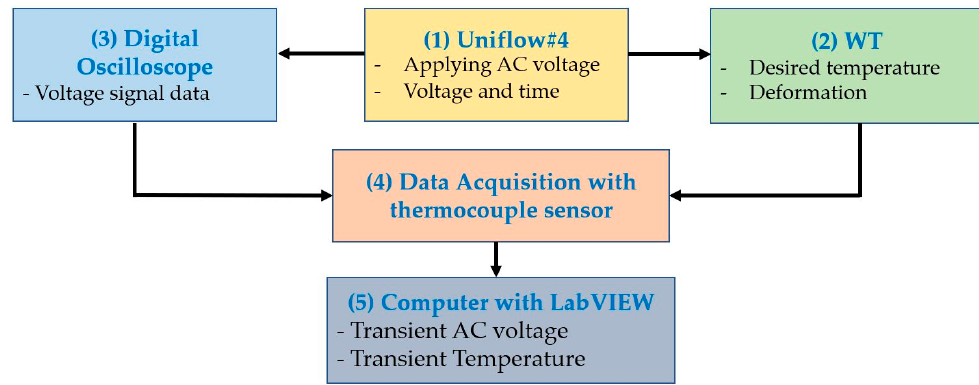
Figure 8. A diagram to summarize the experiment.